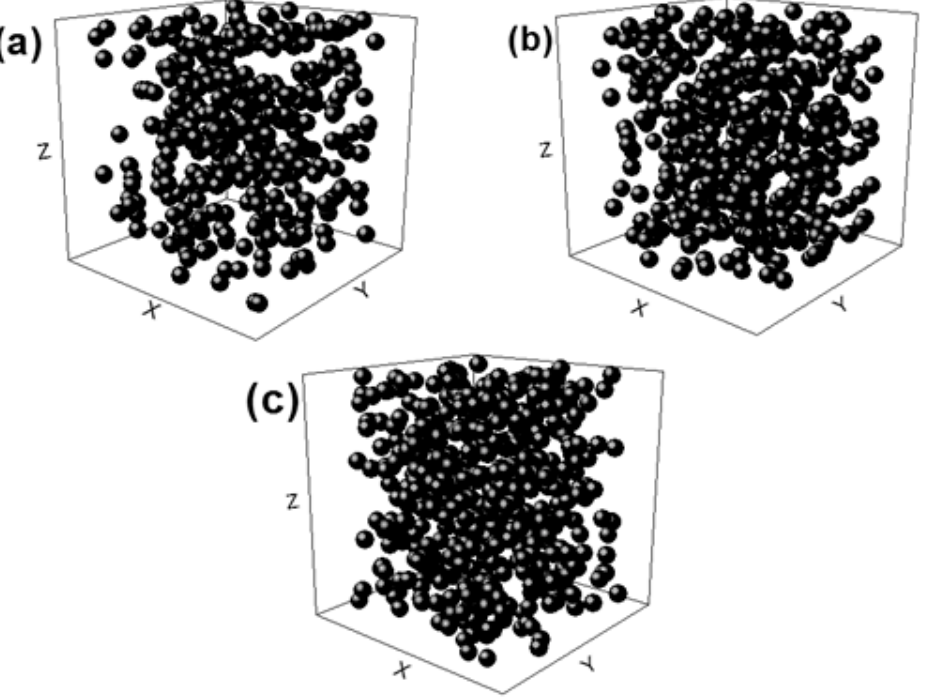
Figure 1. Sphere distributions used to generate the porosity of the foam. ( a ) 40%, ( b ) 50%, and ( c ) 60% porosity, respectively.